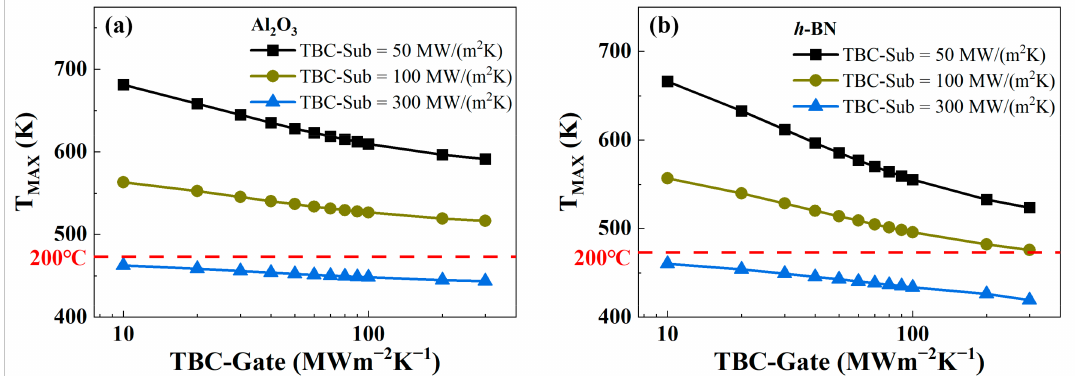
Figure 9. 300 MWm − 2 K − 1 as the gate insulators are ( a ) Al 2 O 3 and ( b ) h